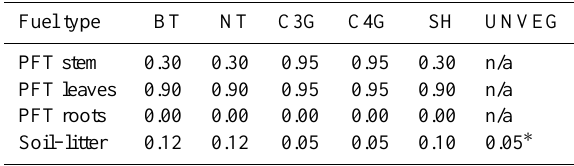
Table 1. Combustion fractions (all unitless) for the different PFTs (BT is broadleaf tree; NT is needleleaf tree; C3G is C 3 grass; C4G is C 4 grass; SH is shrub) and temporarily unvegetated portion of the grid cell (UNVEG); n/a indicates not